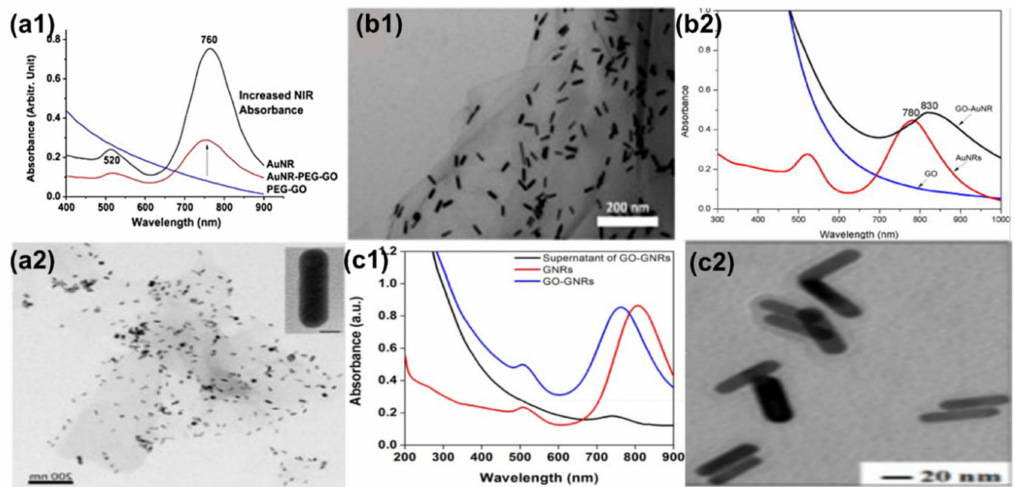
Figure 5. ( a1 ) UV-Vis spectrum of the polyethylene glycol (PEG)–GO molecules, AuNRs, and their assembled composites of AuNRs–PEG–GO, ( a2 ) TEM images of the AuNRs–PEG–GO composites. An enlargement of the AuNRs–PEG–GO composites is shown for a better demonstration of the assembly (scale bars: 200 nm). The inset figure with the 5 nm scale bar indicates an attached single gold nanorod. Adapted from [29], with permission from Wiley, 2013. ( b1 ) TEM image (scale bar: 200 nm) and ( b2 ) UV-Vis spectrum of GO–AuNRs Adapted from ref [115], with permission from Elsevier, 2013. ( c1 ) UV-Vis spectrum of GO–AuNRs and AuNRs. ( c2 ) TEM images of GO–AuNRs (scale bar: 20 nm). Adapted from [118], with permission from RSC advances,